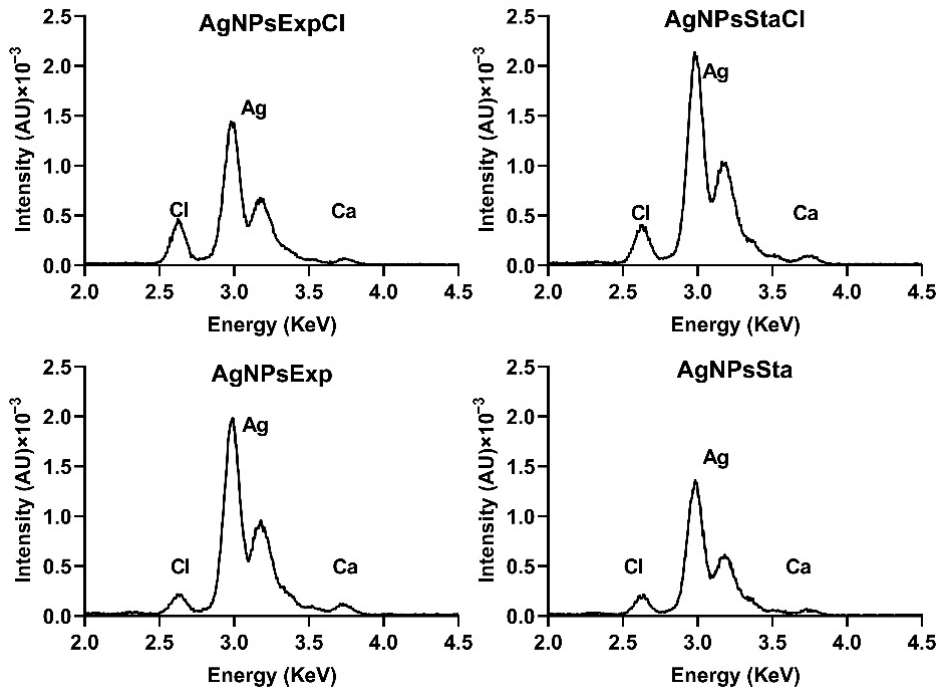
Figure 3. TXRF analysis of elemental composition of AgNPs around the silver peaks. AU: arbitrary units.